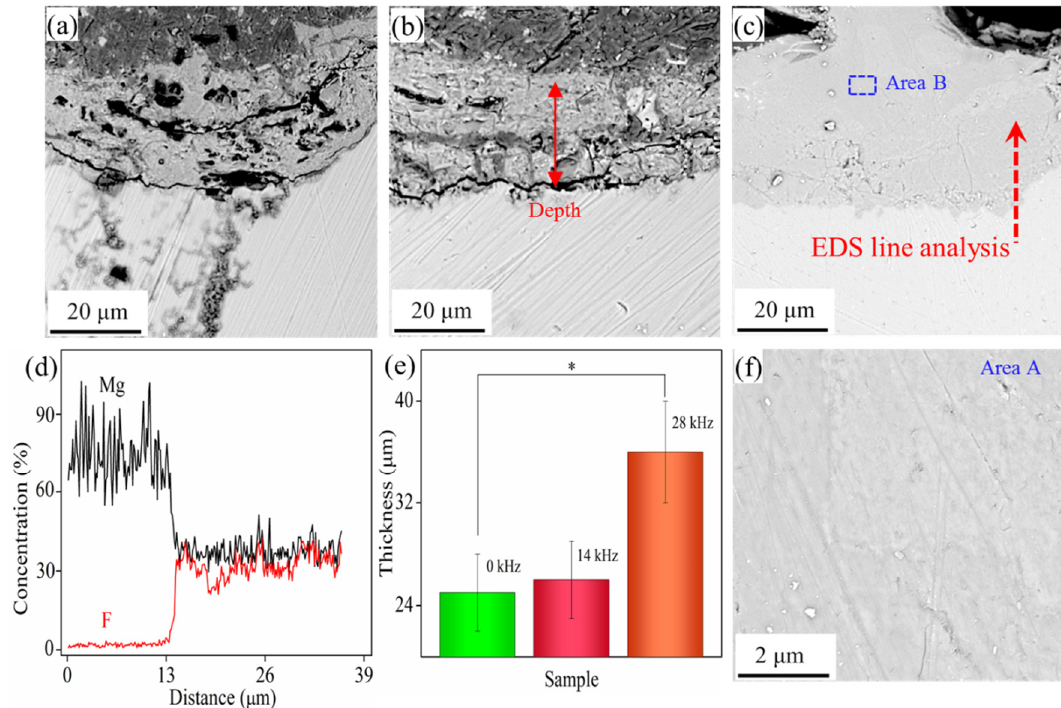
Figure 4. Cross-sections of Mg alloy surfaces of ultrasonically treated fluoride coating at ( a ) 0, ( b ) 14 and ( c ) 28 kHz, respectively; ( d ) compositions along an EDS scan line, ( e ) Average thickness of the MgF 2 layer on Mg alloy and ( f ) enlarged images of area A of the cross-section of Mg alloy surface.